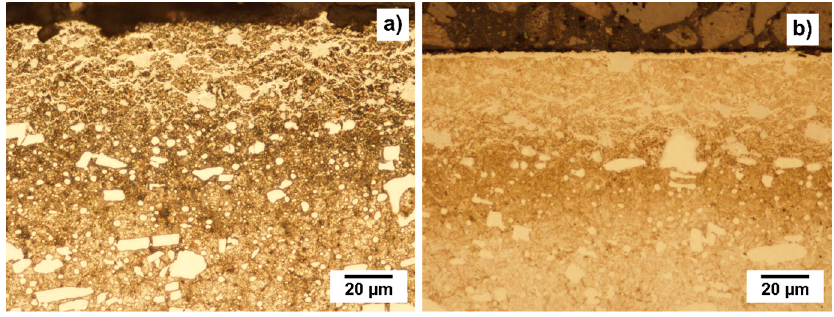
Figure 4. Steel X210Cr12 nitrided layer after: “B” treatment ( a ); and “D” treatment ( b ).